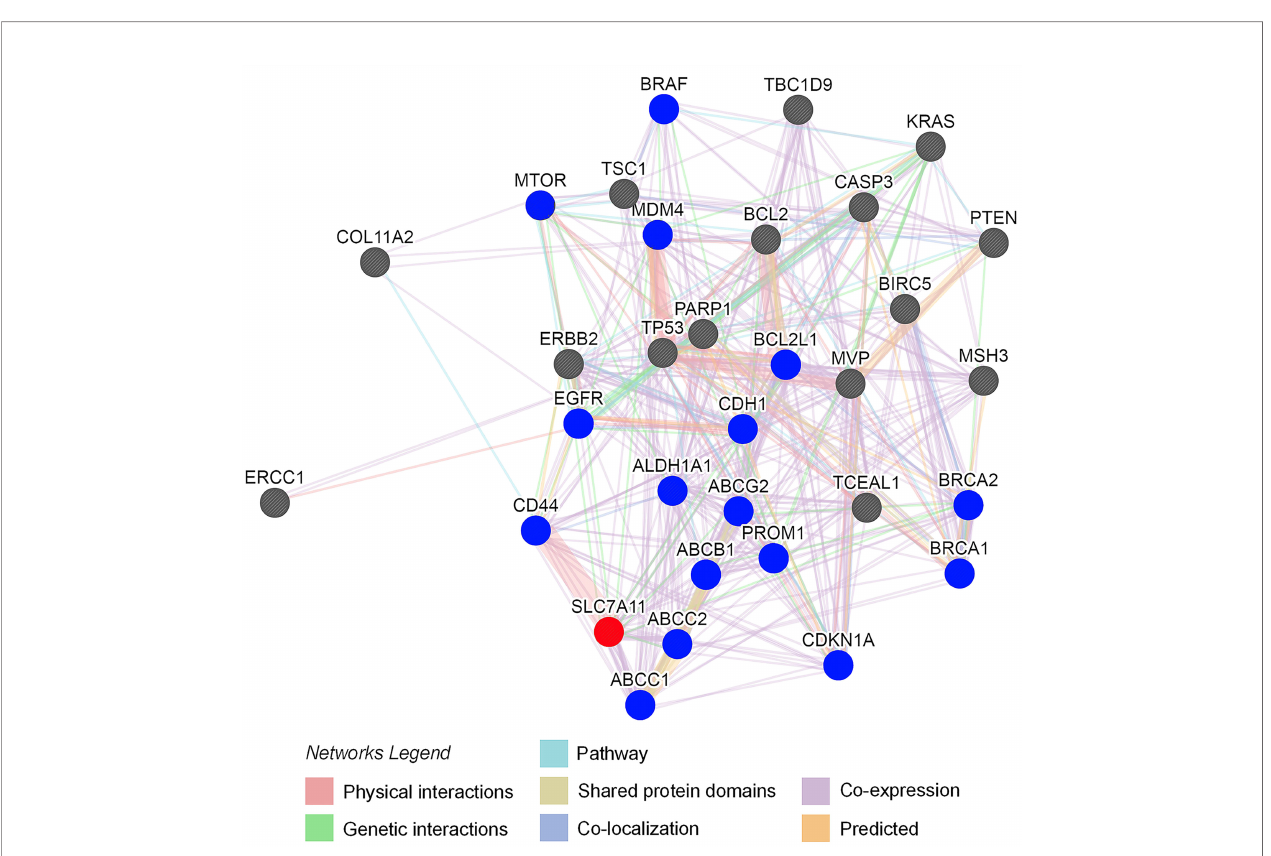
FIGURE 8 | Protein interaction network of SLC7A11 created by the GeneMANIA online tool. The 31 drug resistance-related proteins were text-mined by Coremine Medical ( P < 0.001). The blue circles indicate the 16 proteins which interacted with SLC7A11 directly; the grey circles indicate the proteins which interacted with SLC7A11 indirectly. The interaction types between proteins indicated as networks